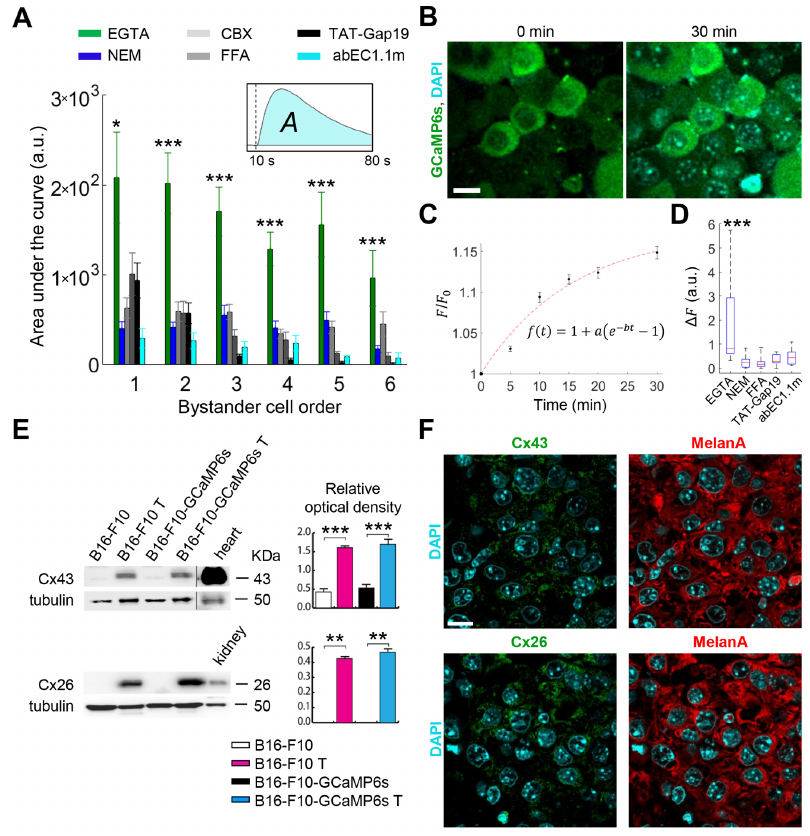
Figure 2. Connexin (Cx) hemichannels (HCs) expressed in melanoma cells mediate the propagation of calcium (Ca 2+ ) waves induced by focal photodynamic therapy (fPDT) in vivo. ( A ) Pooled results of fPDT trials in GCaMP6s-expressing dorsal skinfold chamber (DSC) tumors in the following conditions: Ca 2+ -free extracellular medium (CFEM) supple- mented with ethylene glycol-bis( β -aminoethyl ether)-N,N,N (cid:48) ,N (cid:48) -tetraacetic acid (EGTA, 5 mM); normal extracellular medium containing 2 mM of Ca 2+ (NEM, control); CFEM supplemented with EGTA (5 mM) plus carbenoxolone (CBX, 100 µ M) or flufenamic acid (FFA, 100 µ M) or TAT-Gap19 (150 µ M) or abEC1.1m (1 µ M). The histogram shows the area under GCaMP6s ∆ F / F 0 traces ( A , inset) computed between the onset of fPDT ( t = 10 s) and the end of the observation time window ( t = 80 s) for each bystander cell order (abscissa); pooled data [mean ± standard er- ror of the mean (s.e.m.)] for n ≥ 6 experiments in at least 2 different tumors for each condition. a.u., arbitrary units; *, p < 0.05; ***, p < 0.001, the Kruskal-Wallis test (for post hoc pairwise comparisons, see Table S1). Data for EGTA and NEM conditions are also shown in Figure 1C; ( B – D ) In vivo 4 (cid:48) ,6-Diamidine-2 (cid:48) -phenylindole dihydrochlo- ride (DAPI) uptake experiments: GCaMP6s-expressing DSC melanomas were incubated with DAPI (5 µ M) dissolved in: CFEM supplemented with 5 mM of EGTA; NEM; CFEM supplemented with 5 mM of EGTA plus FFA (100 µ M) or TAT-Gap19 (150 µ M) or abEC1.1m (1 µ M). Fluorescence images were acquired at 5 min intervals up to 30 min; ( B ) Representative images acquired before ( t = 0 min) and after 30 min of DAPI incubation in EGTA conditions; scale bar: 20 µ m; ( C ) Relative variation of nuclear DAPI fluorescence intensity [ F ( t )/ F 0 ] in tumor cells vs. time during dye uptake in EGTA conditions (mean ± s.e.m., n = 20 cells, 2 tumors). The red dashed line was computed by data fitting with the shown function f ( t ) (parameter values: a = − 0.1754, b = 0.0647 min − 1 ); ( D ) Box plots showing the distributions of ∆ F = F (30 min) − F 0 for DAPI measured in n ≥ 12 nuclei for each condition. Red horizontal bars indicate the median. ***, p < 0.001, the Kruskal-Wallis test (for post hoc pairwise comparisons, see Table S2); ( E ) Representative western blots for Cx43 (top) and Cx26 (bottom) expression in tumors (T) derived from B16-F10 or B16-F10-GCaMP6s cells and grown in DSCs (denoted as B16-F10 T and B16-F10-GCaMP6s T, respectively) compared with B16-F10 or B16-F10-GCaMP6s cells grown in culture dishes; graphs on the right show the corresponding relative optical density (mean ± s.e.m., n = 4 independent experiments; **, p < 0.05, ANOVA on Ranks; ***, p < 0.001, ANOVA); Detailed information about the western blotting can be found at Figure S9. ( F ) Confocal fluorescence images obtained by immunostaining with antibodies selective for Cx43 (top left, green), Cx26 (bottom left, green) and MelanA (right, red) in representative sections of melanomas grown in DSCs; nuclei were stained with DAPI; scale bar: 10 µ